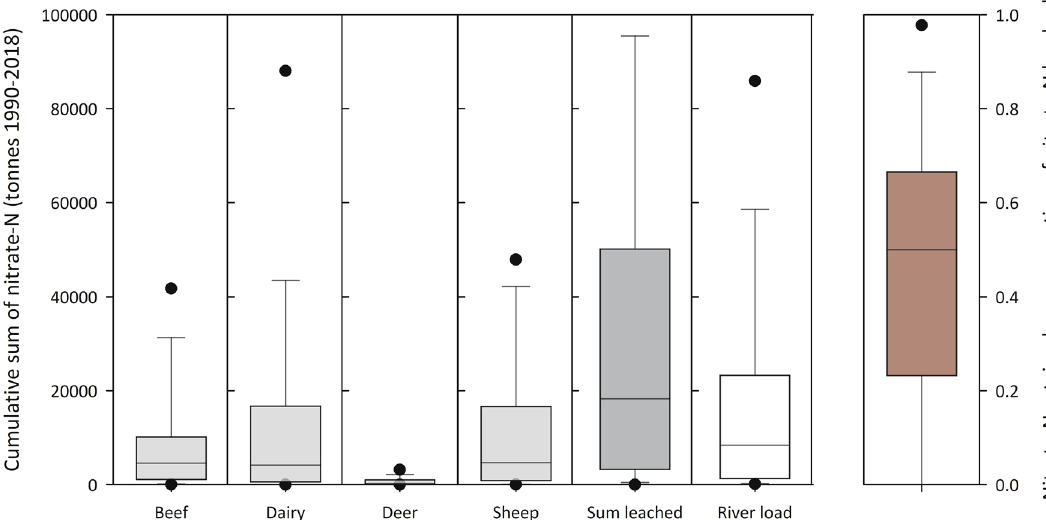
Figure 1. Range of the cumulative sum of nitrate–N leached (tonnes) over 1990–2018 for each livestock class, the sum of livestock classes and the load in the river. Also given is the range of nitrate–N loads retained in the river relative to the sum leached. Boxes describe the 25th, 50th and 75th percentiles, whiskers are the 5 and 95th percentiles. Outliers are indicated by black